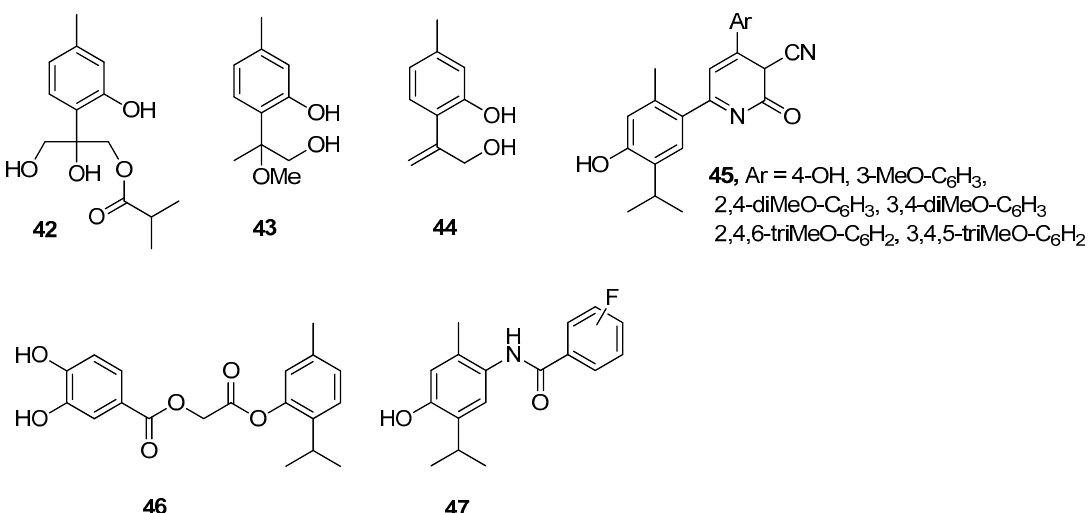
Figure 10. Selected thymol derivatives with significant antifungal activities.